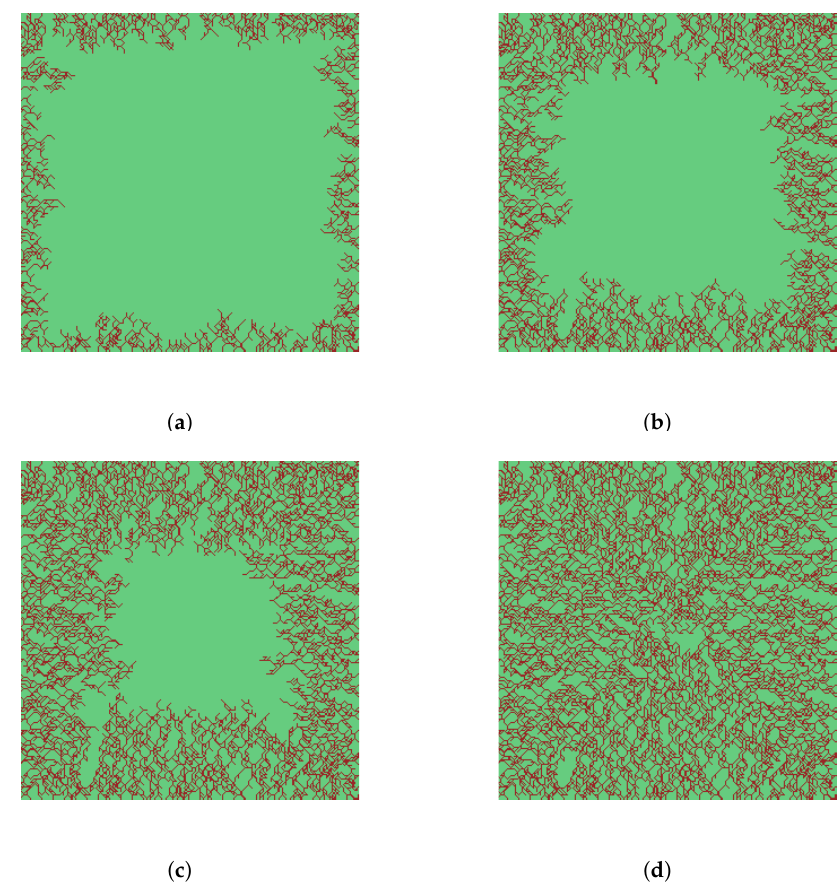
Figure 8. Eden model simulation of angiogenesis for a square skin wound. is wound space and is vasculature growth . Different growth stages of the onset and progression of capillary tips, sprouts, and blocks, showing wound contraction and leading closure, are given in ( a – d ), representing 25%, 50%, 75%, and 100% vascularization, respectively. The capillary growth rate is 1 step and the branching length is 2 steps.